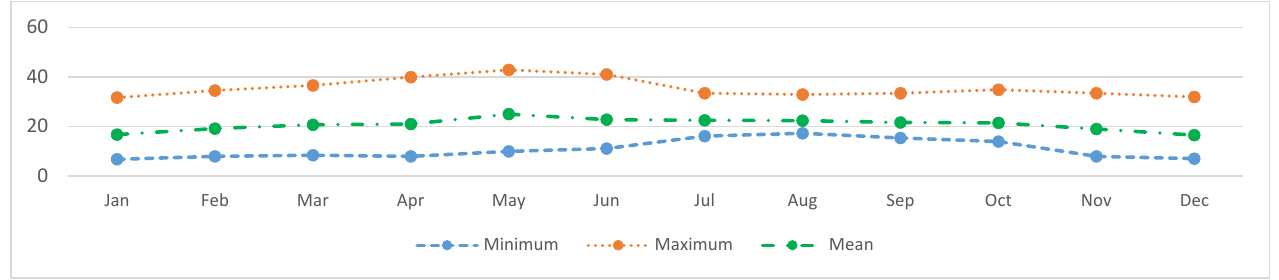
Figure 2. Minimum, maximum, and mean temperatures registered in the greenhouse.